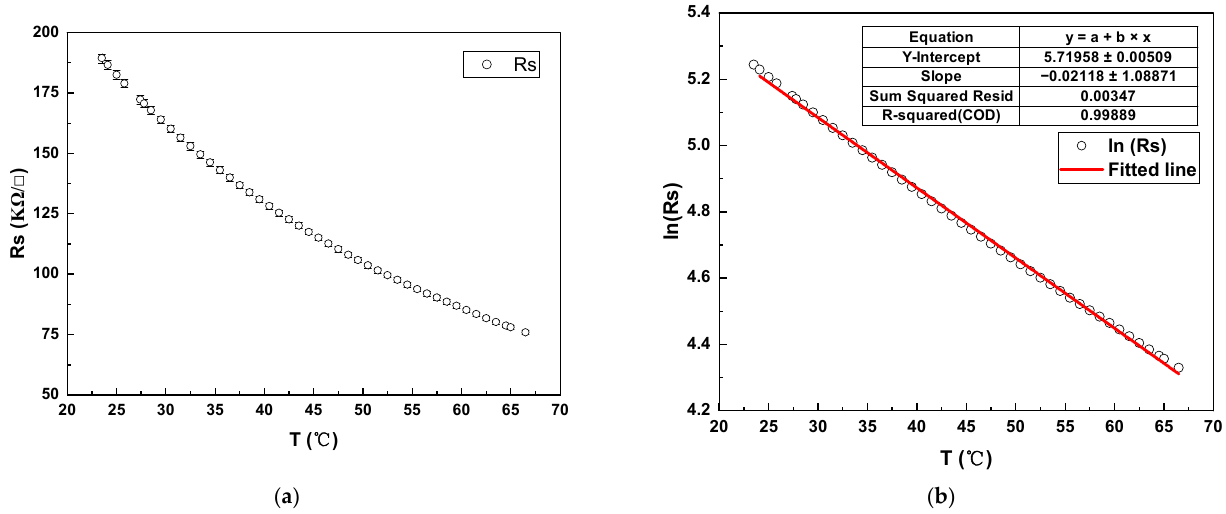
Figure 2. ( a ) Sheet resistance values of VOx films at different temperatures; ( b ) Linearity of ln(Rs) of VOx films versus temperature T.